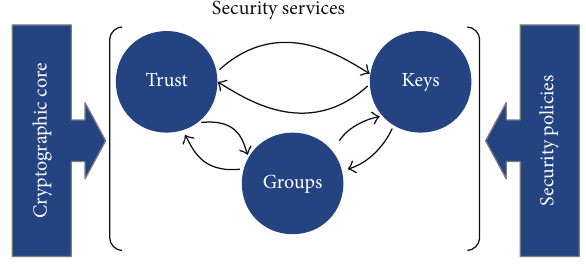
Figure 7: Security module